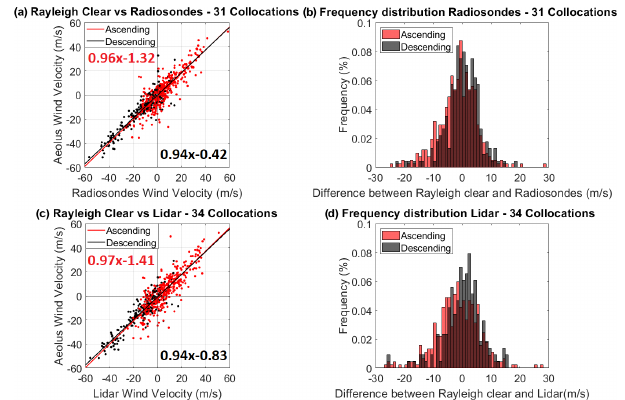
Figure 4. (a) The Aeolus winds versus the radiosonde measure- ments made during all the campaigns. (b) Frequency distribution of the difference between Aeolus and radiosonde wind speeds for the same dataset. Red represents measurements of an ascending orbit, while black represents measurements of a descending orbit. (c) The L2B Rayleigh clear winds versus the lidar measurements made dur- ing all the campaigns. (d) Frequency distribution of the difference between Aeolus and lidar wind speeds for the same dataset. Red represents measurements of an ascending orbit, while black repre- sents measurements of a descending